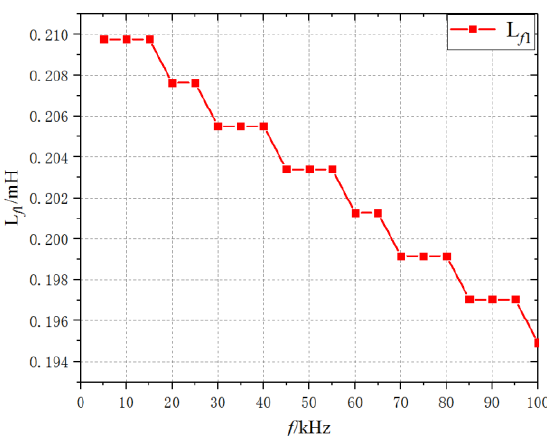
Figure 9. Curve of the compensation inductance with different resonant frequency when the output power is 1 kW.